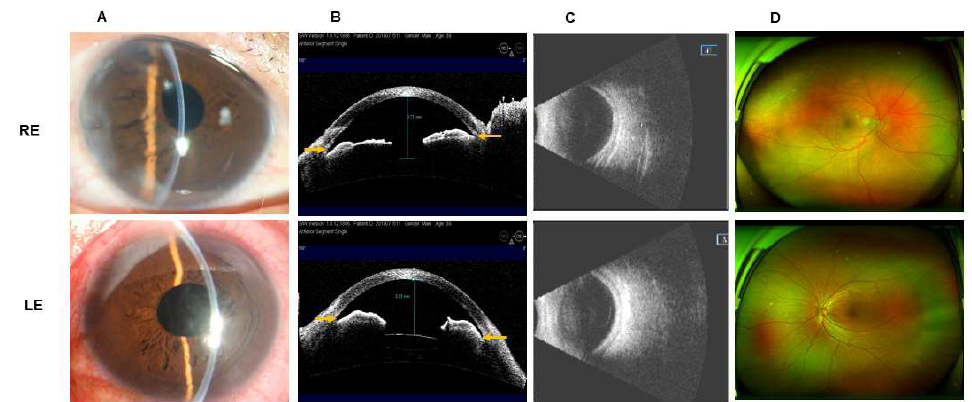
Figure 4. One-day postoperative images of the patient in Figure 1. ( A , B ) Postsurgical anterior segment of both eyes showed significantly increased center ACD (RE: 3.71 mm, LE: 3.33 mm) and open angle (yellow arrow). ( C , D ) B-scan ultrasonography and scanning laser ophthalmoscope showed flat retina in both eyes. RE: right eye, LE: left eye.